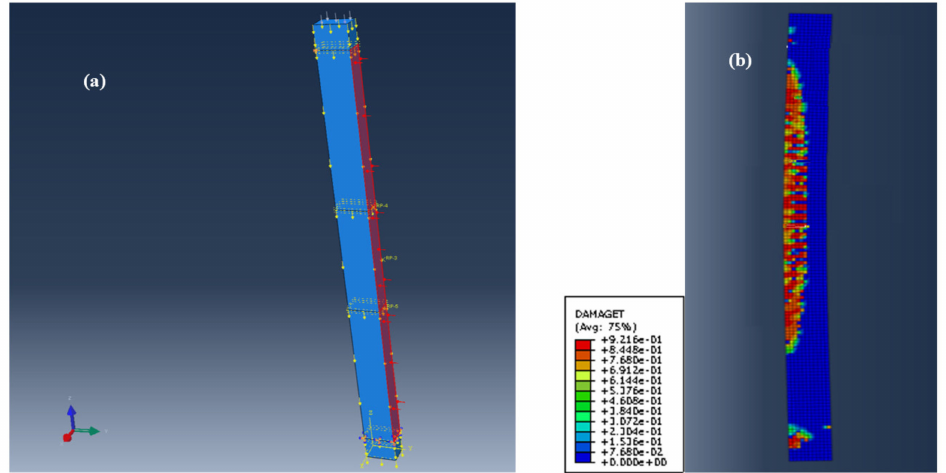
Figure 6. ( a ) Simulation of the pier and the water flow load applied on one face in ABAQUS and ( b ) damage parameter contours and the legends (red shows that the tensile damage parameter is more than one and the blue is zero).